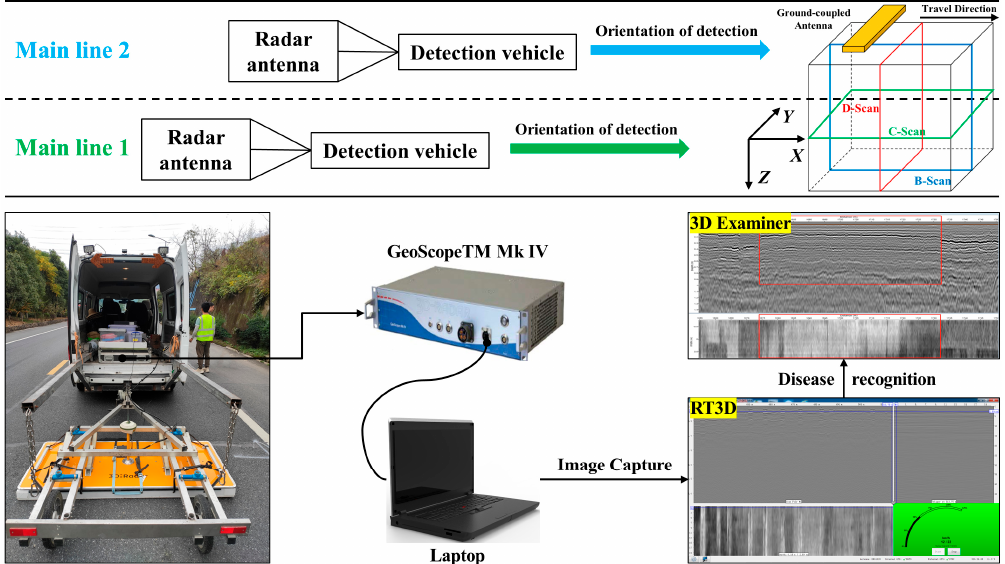
Figure 5. The full field-testing workflow of GPR in Asphalt pavement (B-scan indicates the longitudinal vertical section, C-scan indicates the horizontal section, and D-scan indicates the lateral vertical section).